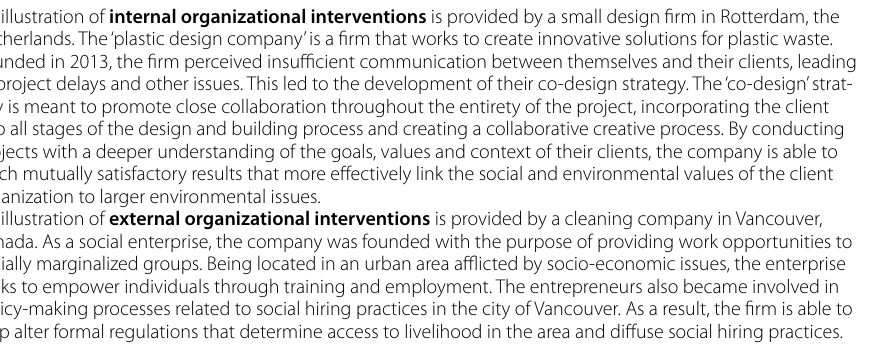
Table 4 Illustrative examples of organizational